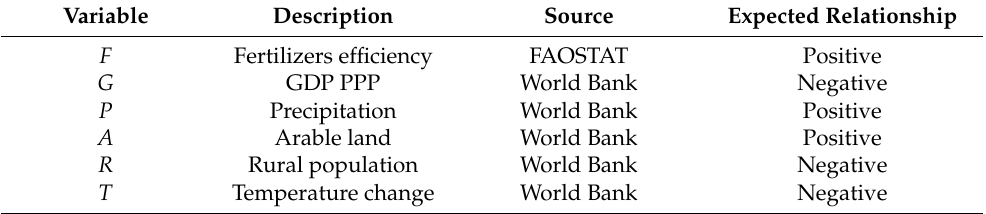
Table 2. Explanatory